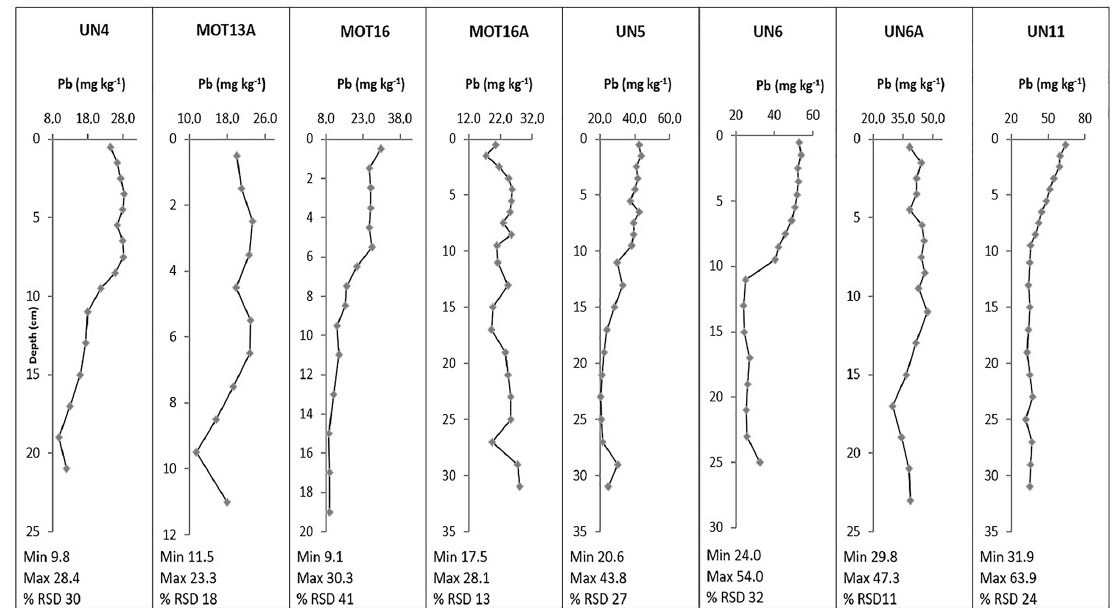
Figure A12. Vertical distributions of Pb (in mgkg − 1 ) in sediment cores. The concentrations in the coarse cores MOT13A, MOT16 and UN4 refer to the total sediment fraction ( <